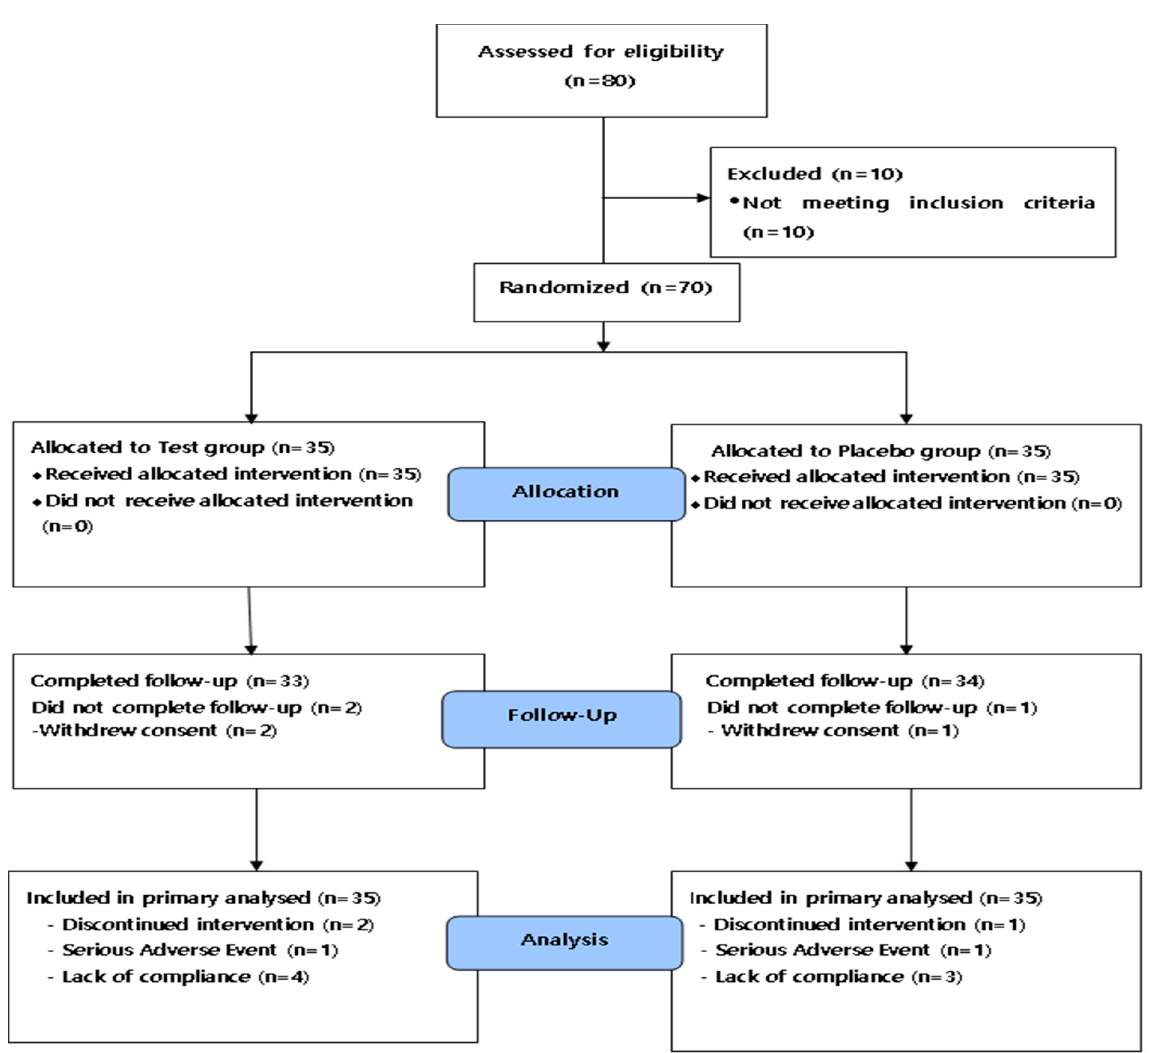
Figure 2. Flow diagram showing the selection and allocation of participants in the study. Table 2. Demographic characteristic of study participants.